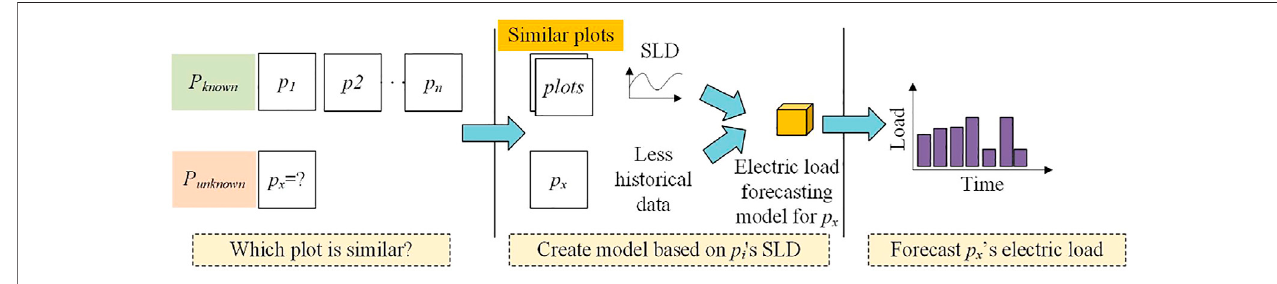
FIGURE 1 | Basic principle of using SLD for SLF.